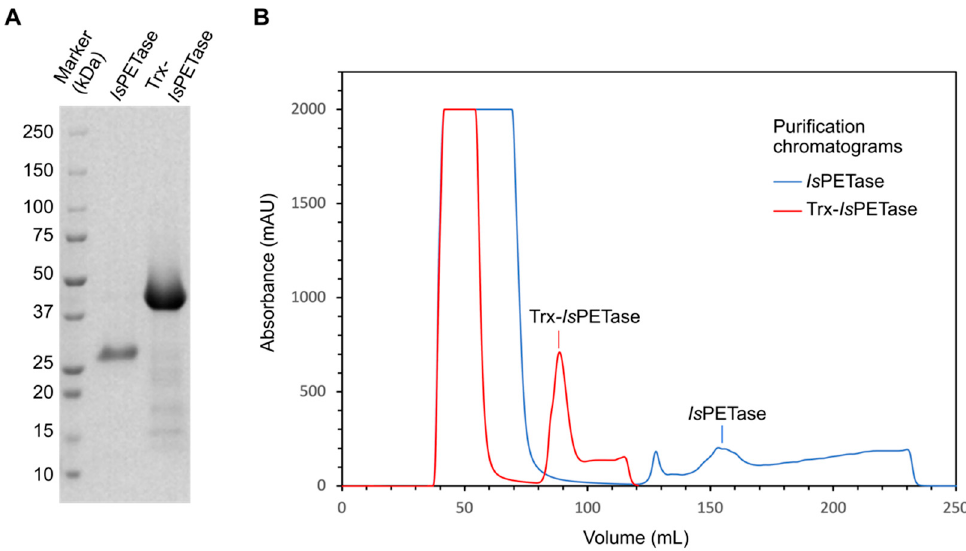
Figure 2. Purification analysis of Is PETase and Trx- Is PETase. ( A ) SDS-PAGE. ( B ) IMAC purification chromatograms. The sharp peak at 130 mL of elution in the Is PETase purification chromatogram corresponds to impurities. Table 1. Production of recombinant Is PETase in different systems.